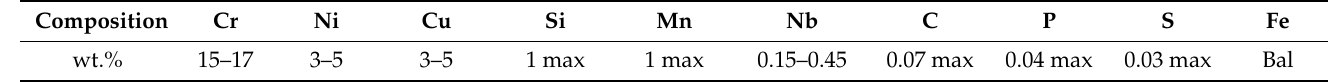
Table 1. Composition of the 17-4 ss